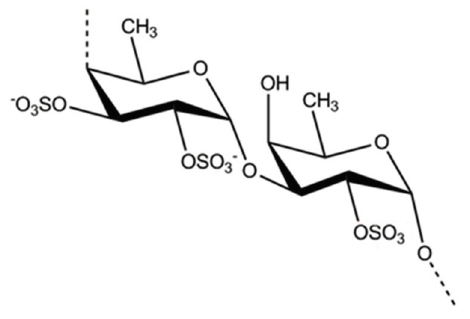
Figure 3. The structure of fucoidan ( 12 )